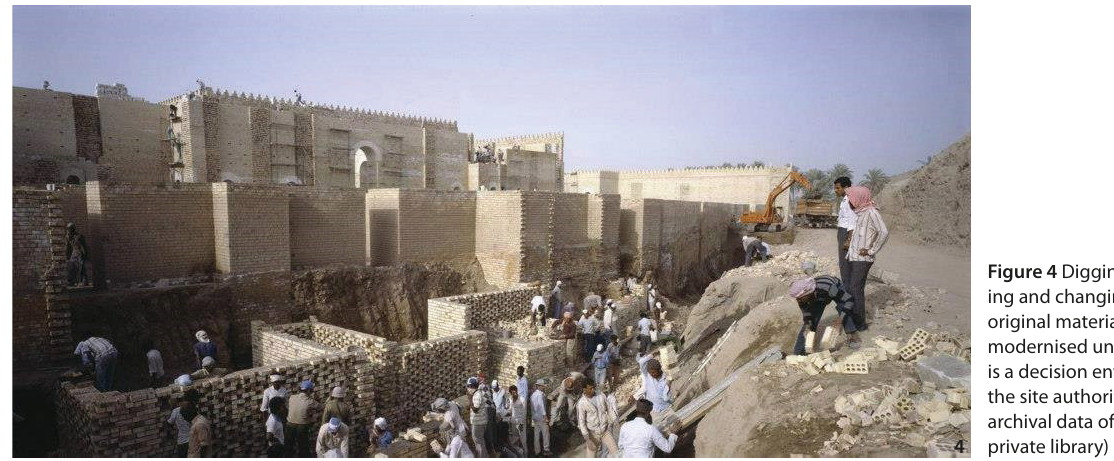
Figure 4 Digging, build- ing and changing of the original material with modernised units, which is a decision entrusted to the site authorities (Source: archival data of Babylon’s private